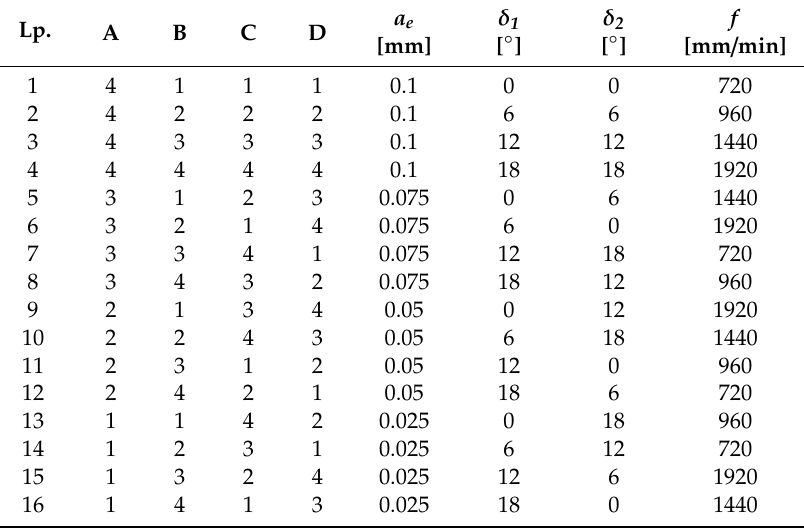
Table 5. Taguchi L16 orthogonal table with values of analyzed